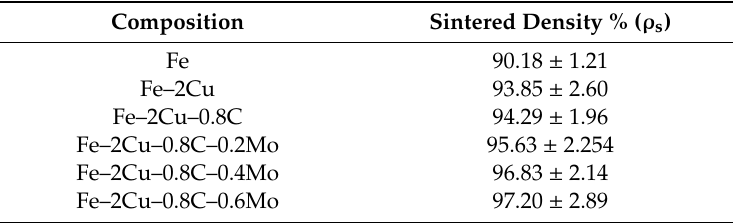
Table 3. E ff ect of varying alloying addition on the densification response of carbonyl iron powder compacts sintered in Spark plasma heating furnace [21].